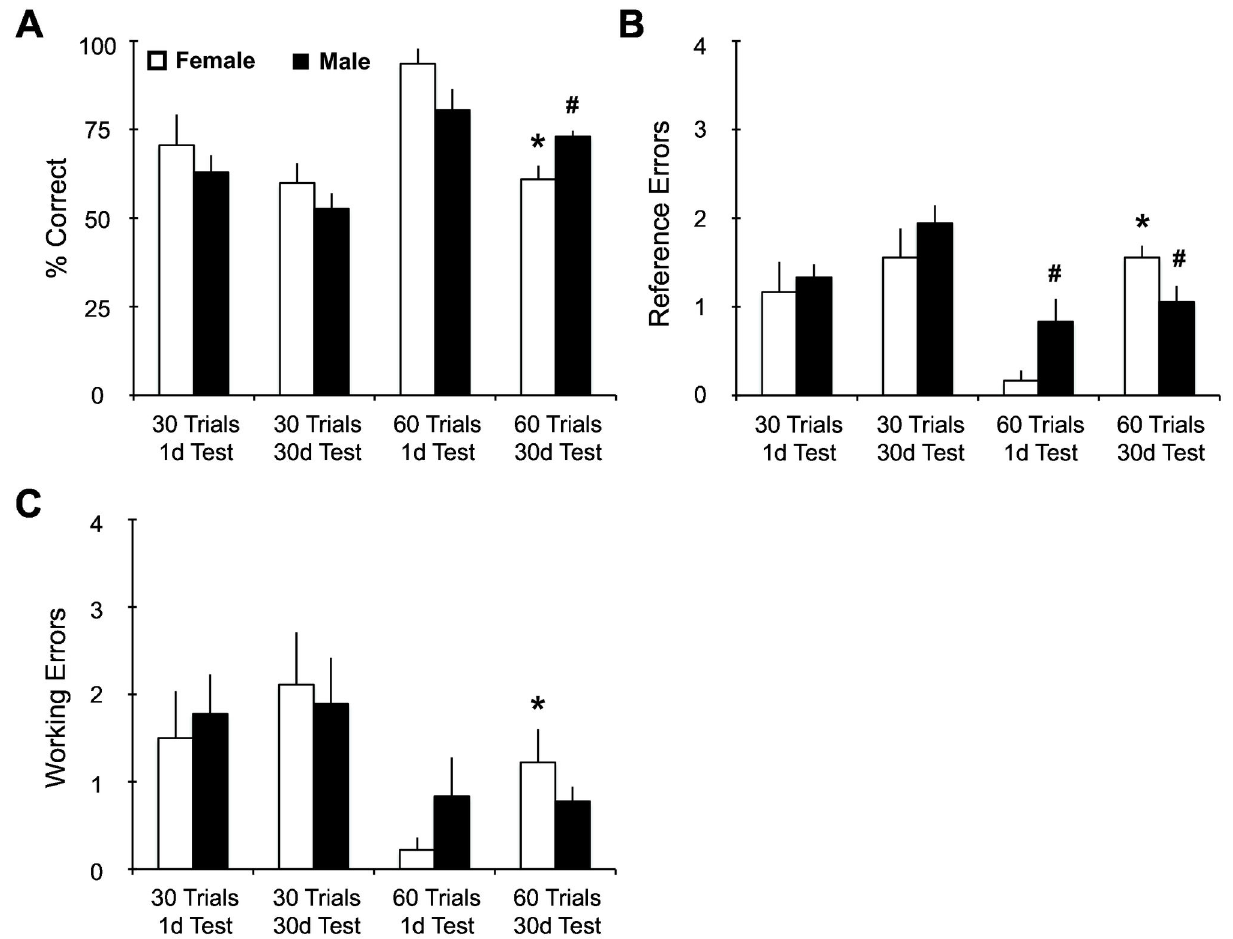
Figure 2. Memory retention test scores1d and 30d post training. (A) Overall performance on the retention test showed significant training and retention period effects. The 60-trial cohorts showed significantly better retention compared to 30-trial cohorts. In the post-hoc analysis, there were no differences between sexes in the 60 trial / 1d test condition. Females in the 60 trial / 30 d test group showed significantly lower retention scores compared to males of the same condition and compared to their female 1d counterparts. (B) Reference memory errors showed significant training and retention period effects. The post-hoc analysis showed that females trained for 60 trials and tested 30d later make significantly more reference errors compared to males of the same condition and compared to their female 1d counterparts. (C) Working memory errors revealed significant training effects, with 60-trial cohorts making significantly fewer errors compared to 30-trial cohorts. In the post-hoc analysis, females trained for 60 trials and tested 30d later showed a significant increase in working errors compared to 60 trials / 1d test females. For all graphs, pound (#) denotes sex significance compared to female counterparts in the same training/testing condition. Asterisk (*) denotes significance compared to same-sex counterparts in the 60 trial / 1d test condition. doi: 10.1371/journal.pone.0081121.g002 may be using different mechanisms to upregulate GluA2, in lieu between retention test scores and synaptic PKMζ expression of increasing PKMζ within the synaptic fraction. (R = 0.451, p<0.05). In addition, both males and females showed a significant correlation (Figure 4C-D) between Synaptic PKMζ and GluA2 correlation analysis retention score and synaptic GluA2 (female R = 0.488, p<0.05; male R = 0.571, p<0.01). These correlations, involving all the After combining all training and testing conditions together, subjects from both 30- and 60-trial cohorts, strengthen our neither males nor females showed a significant correlation understanding of synaptic markers and their participation in between retention test scores (percent correct) and cytosolic memory, particularly in the 30-trial cohorts where group effects PKMζ expression (data not shown). In contrast, males, but not were not significant. females, showed a significant correlation (Figure 4A-B)